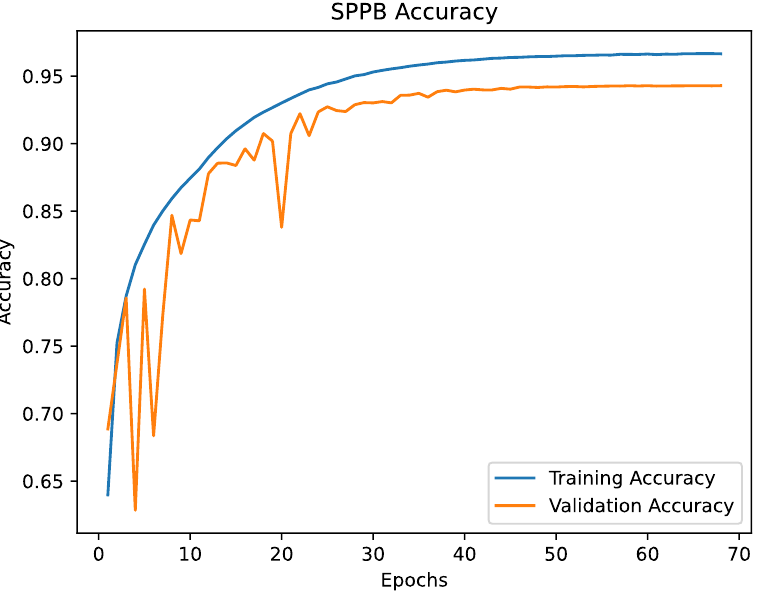
TUG model. For Figure 4. The loss of the SPPB model. For Figure 3. The loss of the the first 25 epochs the loss indicates that the learning rate is slightly too large. From